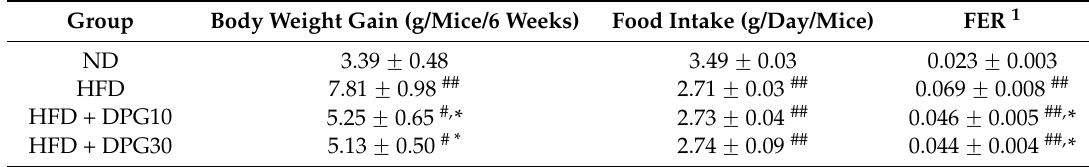
Table 1. Effect of DPG on body weight gain, food intake and FER.